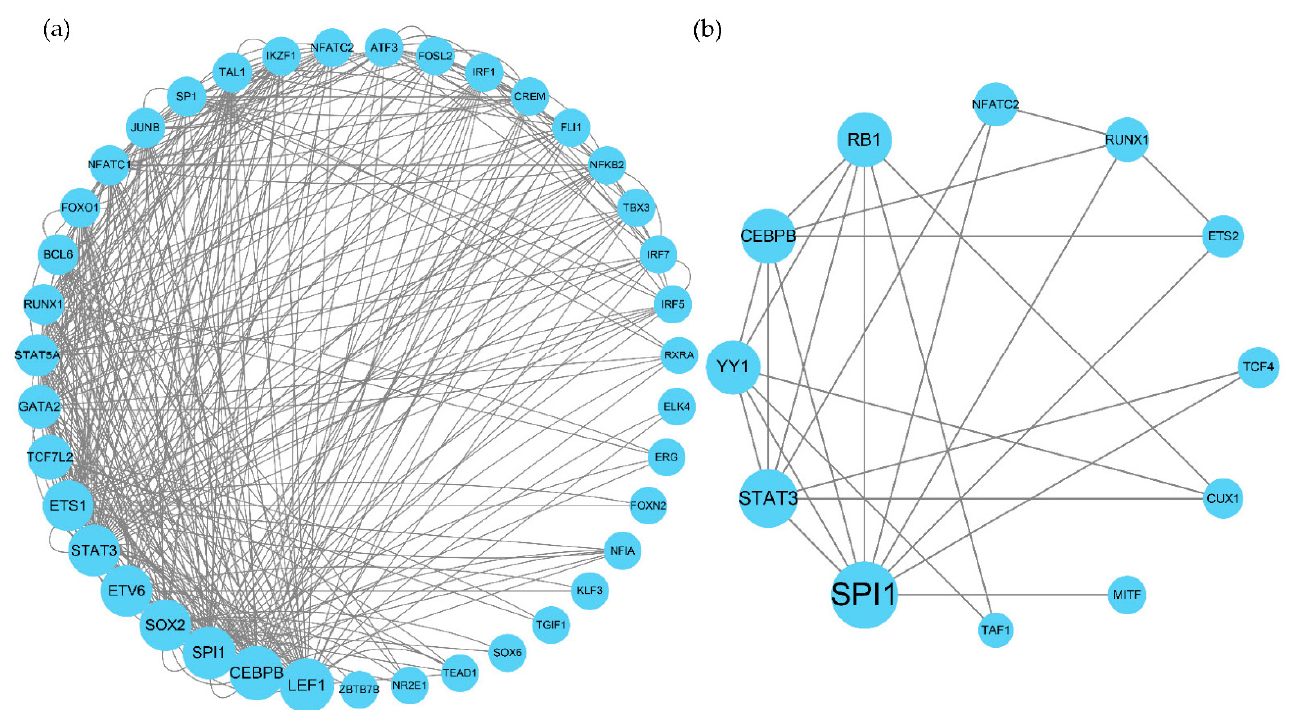
Figure 5. PPI network constructed by STRING and ranked using centrality indicators. The size of the gene depends on the centrality indicators, from small to large indicating increasing centrality. ( a ) Black module regulators building PPI networks. ( b ) MG1 cluster-specific regulators building PPI